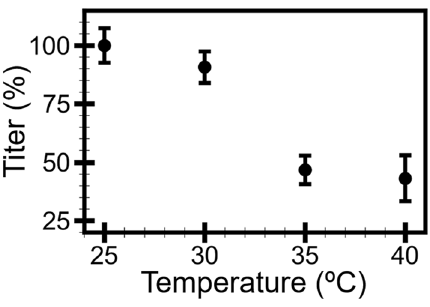
Figure 1. Relative titers of C22 phage at 25, 30, 35, and 40 °C. The titer measurement was conducted in triplicate, and the error bar represented standard deviations